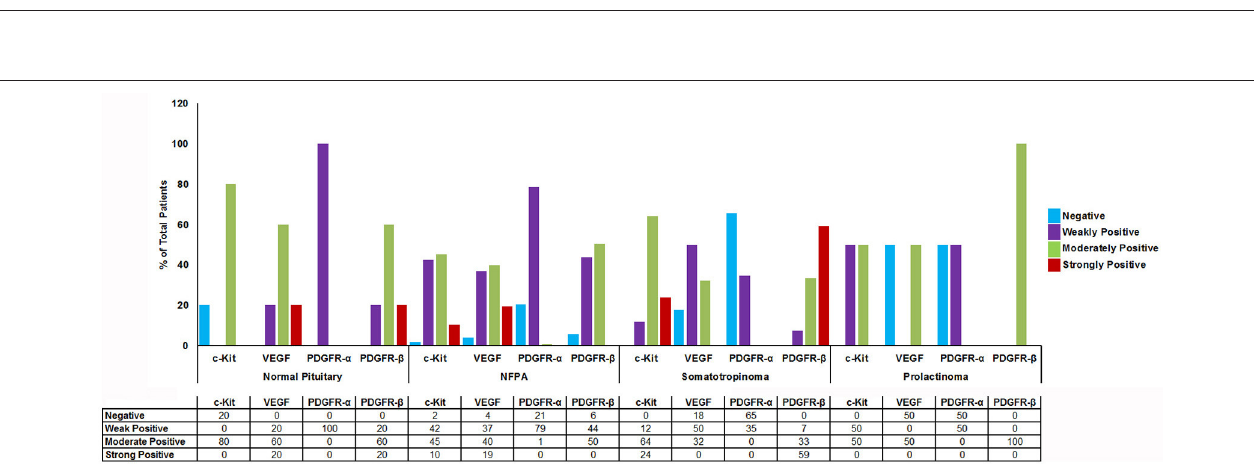
FIGURE 3 | Graph showing percentage of cytoplasmic TK (c-Kit, VEGF, PDGFR- α / β ) immunostaining in normal pituitary ( n = 4), NFPAs ( n = 121), somatotropinomas ( n = 32), and prolactinomas ( n = 4). c-Kit showed moderate to strong positivity in somatotropinomas. VEGF showed higher percentage of positivity in NFPA. PDGFR- β was strongly positive in maximum number of somatotropinomas (59%), whereas PDGFR- α was negative (65%).